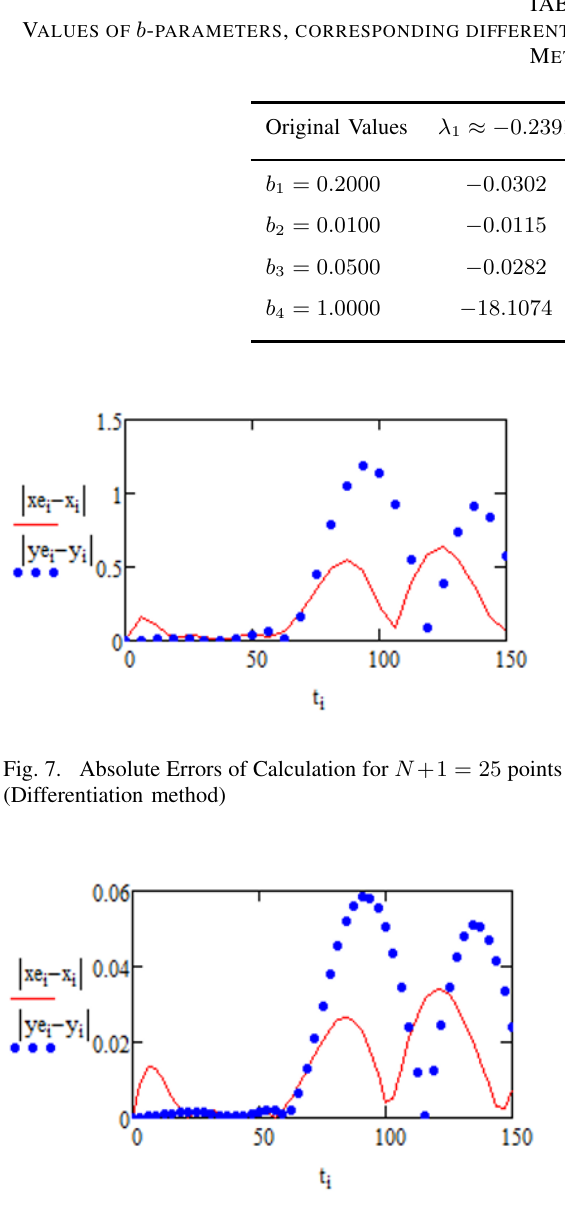
Fig. 8. Absolute Errors of Calculation for N +1 = 49 points (Differentiation method)